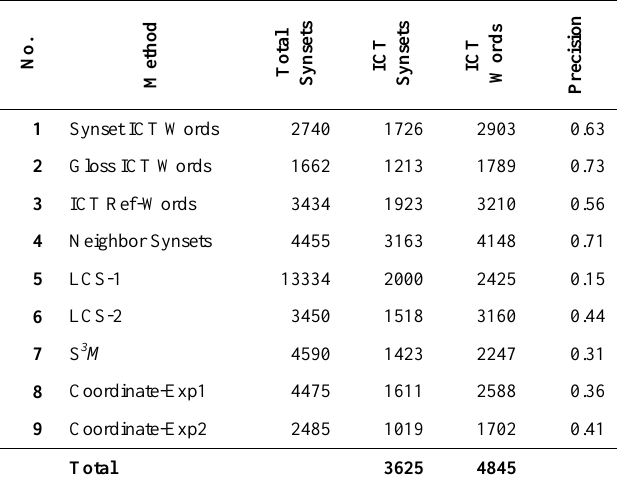
Table 6. Overall ICT data statistics.